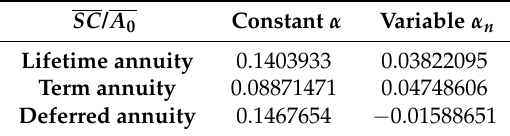
Table 2. Comparison of the annuities at t =